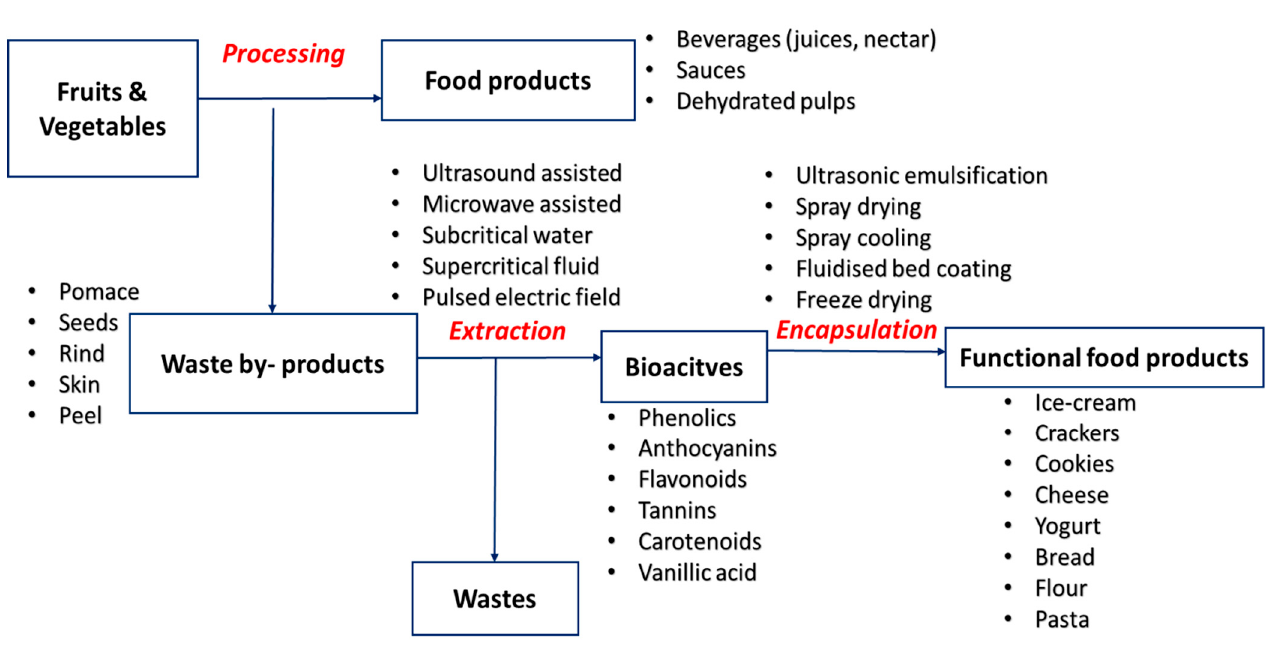
Figure 1. Overview of the utilization of the fruit and vegetables (F&V) by-products from the extraction of bioactive components to food product development.